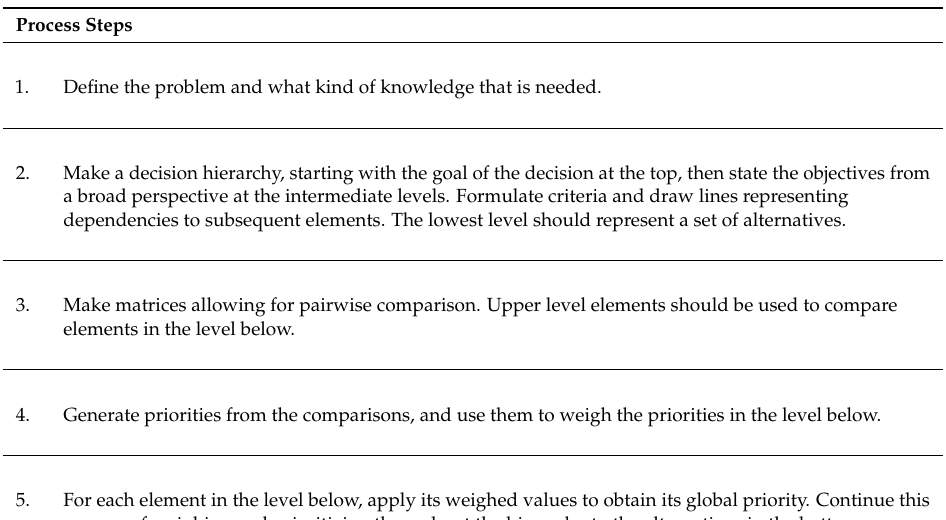
Table 2. Example of a rational decision-making technique, illustrating the systematic